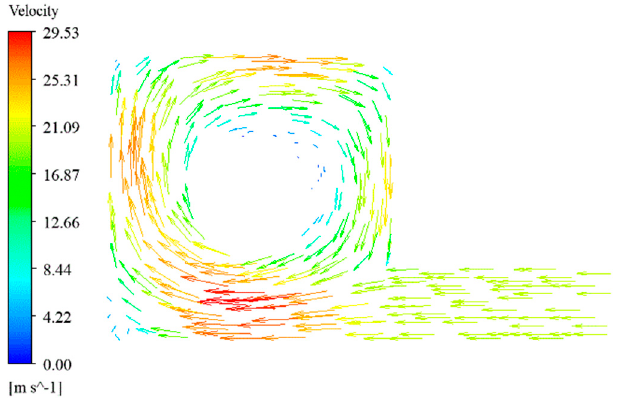
Figure 7. Velocity vector at y = 9 m.